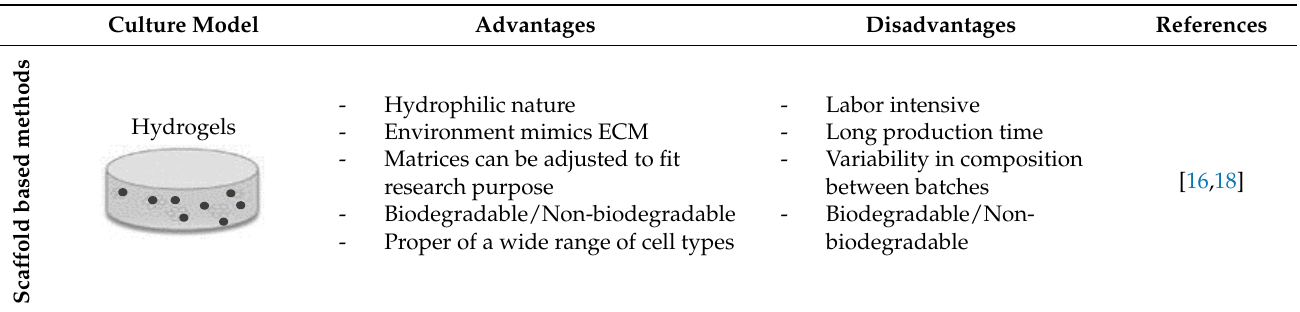
Table 1. Three-dimensional spheroid-generating systems.